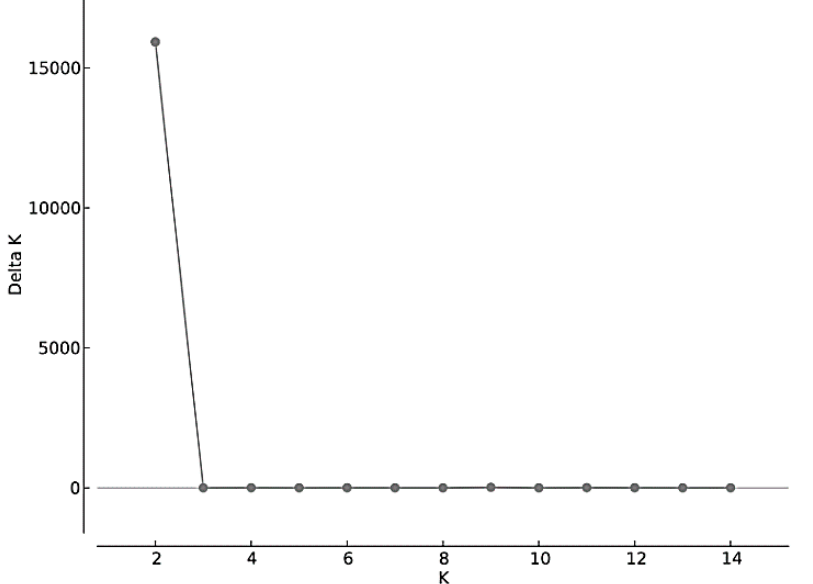
Figure 5. Delta K results from the Structure Harvester Evanno method. STRUCTURE tested 15 clus- ters (K = 1–15) with eight replicates each using 10,111 SNPs and 179 Petaurus individuals. Two clus- ters were detected (K = 2) using DeltaK = mean(|L”(K)|)/sd(L(K)).